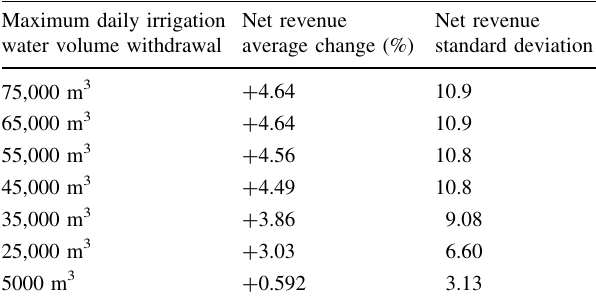
Table 5 Sensitivity analysis illustrating average net revenue change when maximum daily irrigation water volumes on irrigated crops were varied (base maximum daily irrigation water volume